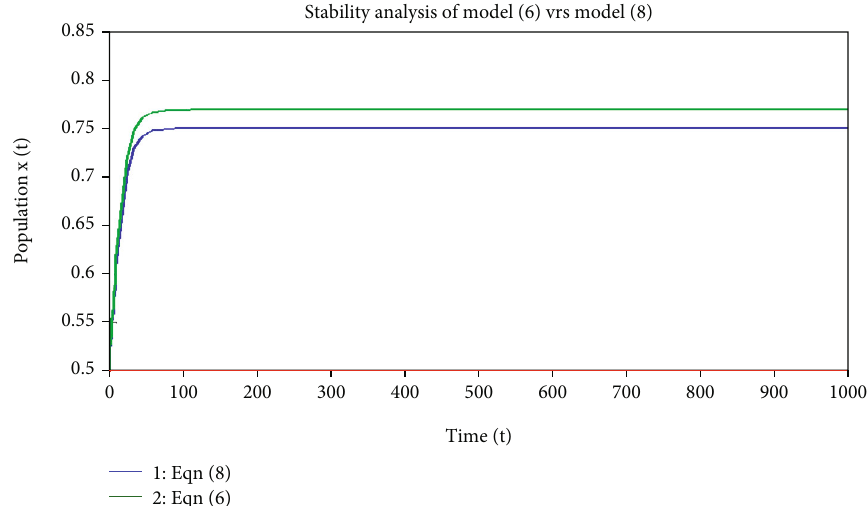
Figure 5: Stability analysis of equations (6) and (8) with r = 0 : 1 , τ = 3 : 00, and h = 0 : 025 .